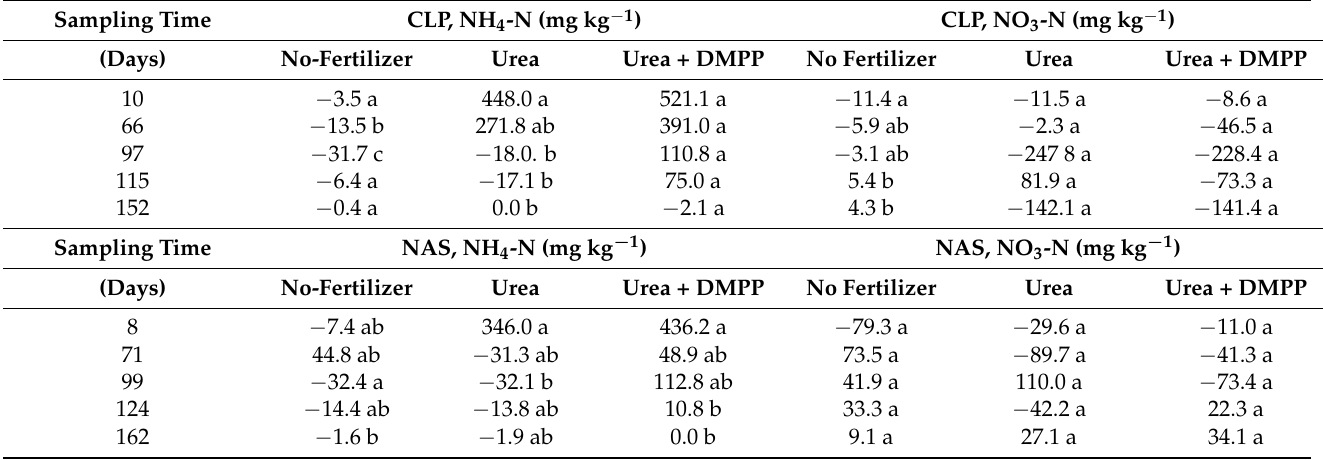
Table 3. Exchangeable NH 4 -N and NO 3 -N in soil from root exclusion cylinders after applying urea and DMPP-coated urea in the 2016/17 season. Results for 2M KCl extraction of water extracts (soluble or loosely bound N species) were subtracted from 2M KCl soil extraction results. Column values with the same letter are not significantly different at a 5% probability